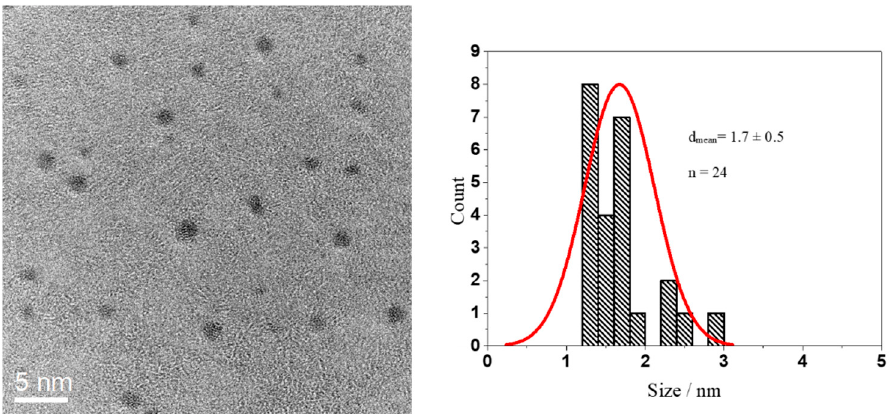
Figure 1. HRTEM image of Au-GSH nanoparticles ( left ) and particle size distribution ( right ).